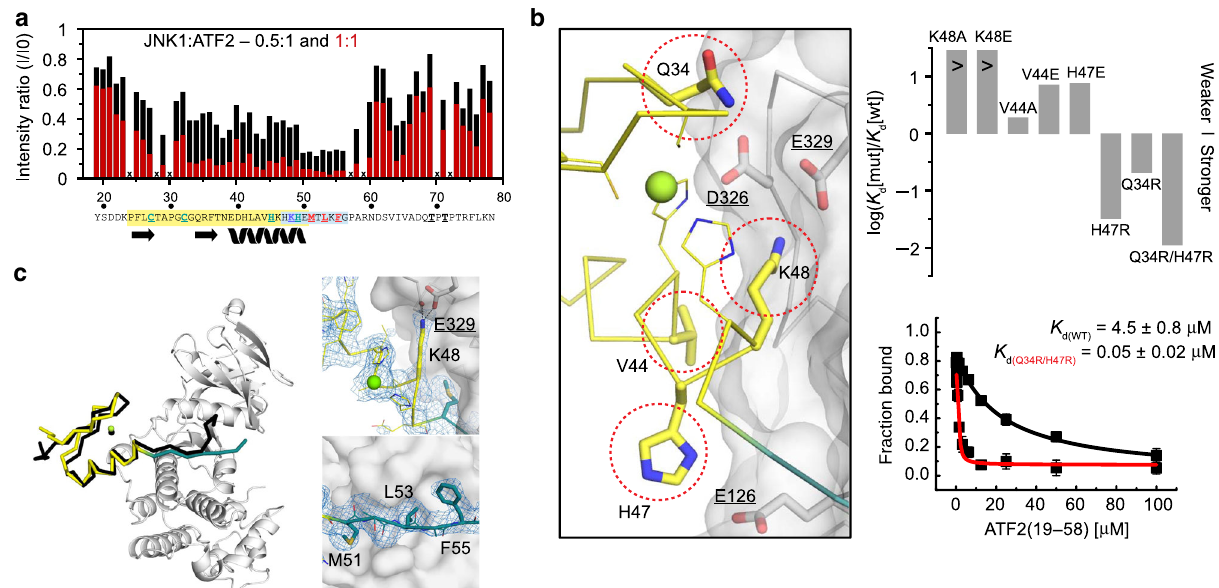
Fig. 2 Structure of the JNK1-ATF2 complex. a Interaction region mapping by NMR. 15 N-labeled ATF2(19-78) was mixed with JNK1 in two different molar ratio, and intensity changes, normalized to the peak intensity without JNK1, for ATF2 1 H- 15 N HSQC peaks for the 0.5:1 (black) or 1:1 (red) JNK1:ATF2 experiment were plotted. ‘ x ’ indicates resonances of residues which are not resolved in the spectra and, therefore, could not be quanti fi ed or prolines. b Analysis of the JNK-ATF2(Zn- fi nger) protein – protein binding interface based on the HADDOCK model. Amino acid residues lying at the interface (Q34, V44, H47, and K48) were mutated to alanine, glutamate or arginine. The binding af fi nity of mutant ATF2(19 – 100) constructs (mut) were compared to that of the wild-type (wt) (Supplementary Fig. 4). The panels on the right show the summary of competitive fl uorescence polarization based protein – protein binding assay results on top and the competitive binding curves for the wild-type (black) and for the Q34R/H47R double mutant (red) below. Error bars on the binding isotherms show SD based on three independent measurements ( n = 3). Date are represented as mean values± SD. c Crystal structure of the JNK1-ATF2(19 – 58) complex. The left panel shows the superposition of the HADDOCK model (black) with the crystal structure (yellow + cyan; the RMSD of C α atoms for the ATF2(24-55) region using JNK as the reference, was 0.9 Å). Panels on the right show zoomed-in views at the CD-groove highlighting K48 (top) or at the hydrophobic groove highlighting M51, L53, and F55 (bottom) from the ATF2 D-motif. The simulated annealing Fo-Fc omit map of ATF2 is shown at 1.5 ϭ . Source data are provided as a Source data fi